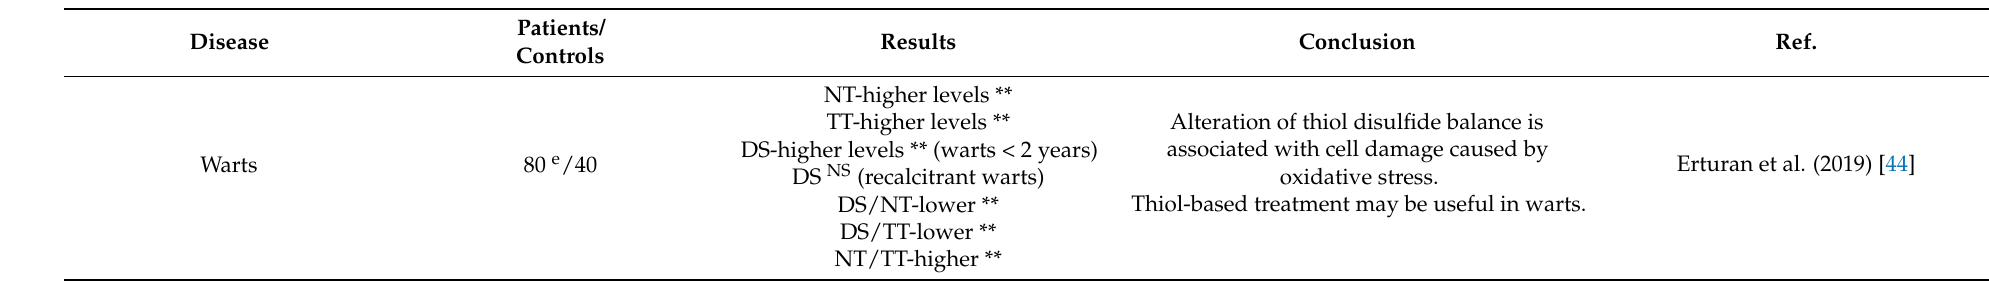
Table 3. Data on TDH parameters in infectious skin